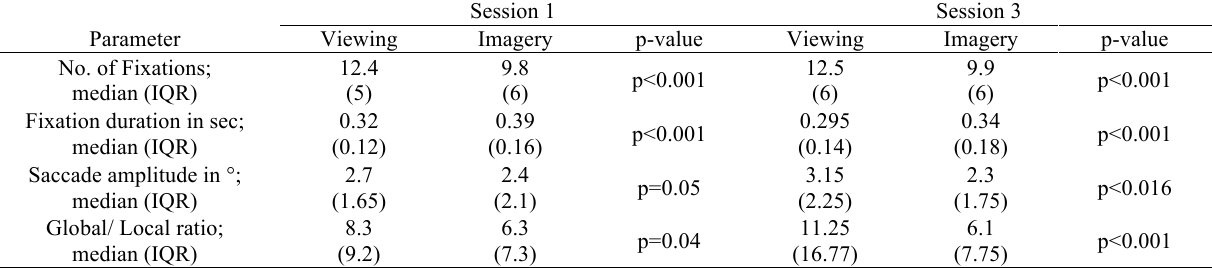
Table 1. Group comparison of basic scanpath parameters of visual imagery and viewing in SH subjects (IQR, interquartile range). Significant differences were found between number of fixations, duration of fixation, saccades amplitudes and global/local ratio in eye movements during visual imagery versus eye movements during regular viewing of